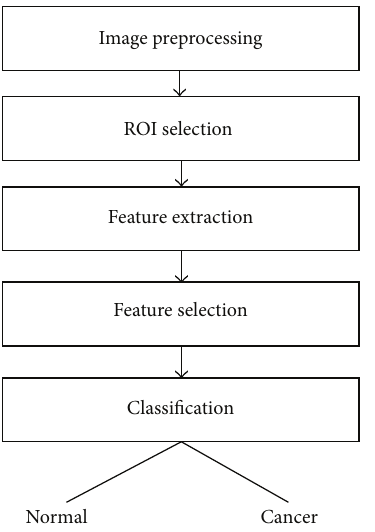
Figure 1: Block diagram of the proposed fully automated CAD